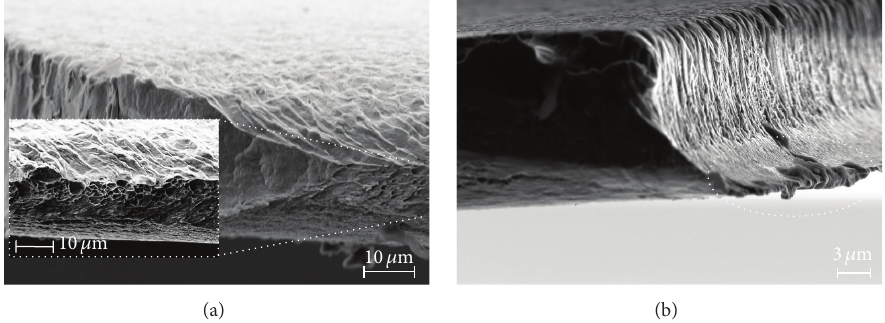
Figure 7: SEM image of fracture area (a), with significant necking. SEM image of the rough edge surface of an as-deposited dog-bone sample (b). The highlighted “feet” arises due to shadowing effects of the galvanic deposited Cu during sputtering on the substrate